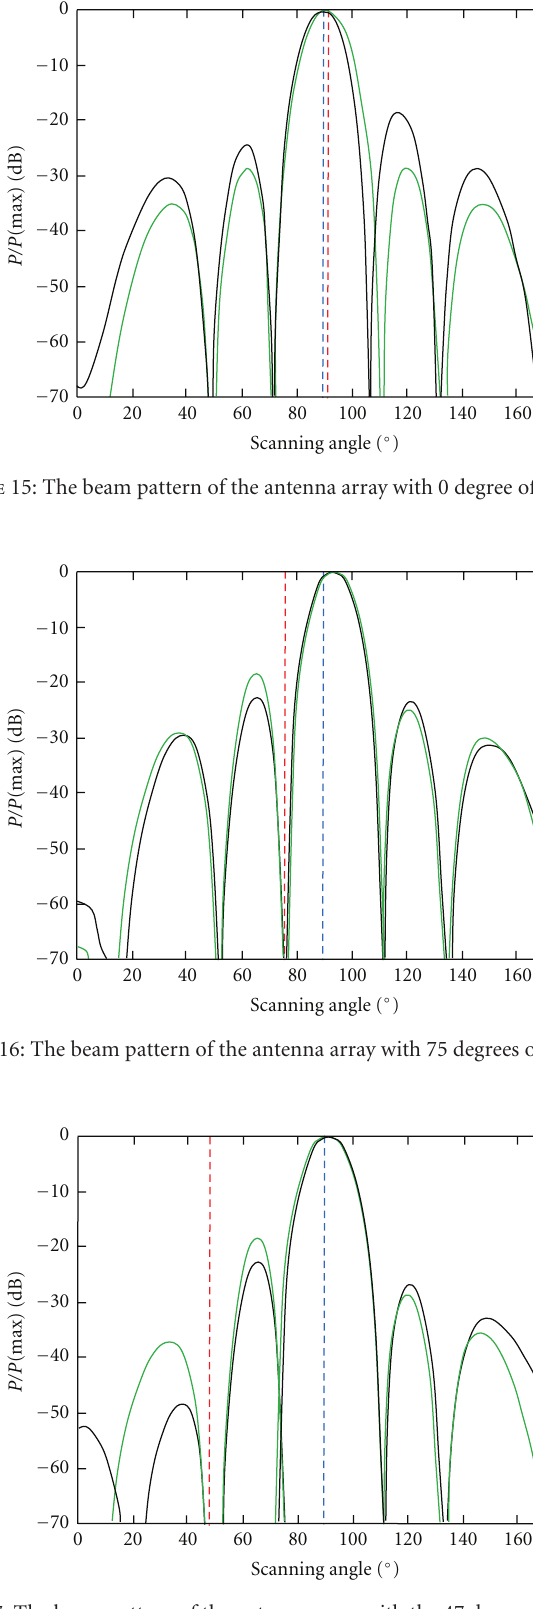
Figure 17: The beam pattern of the antenna array with the 47 degrees of